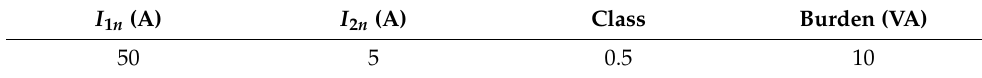
Table 3. Current transformer CT1: rated specifications.